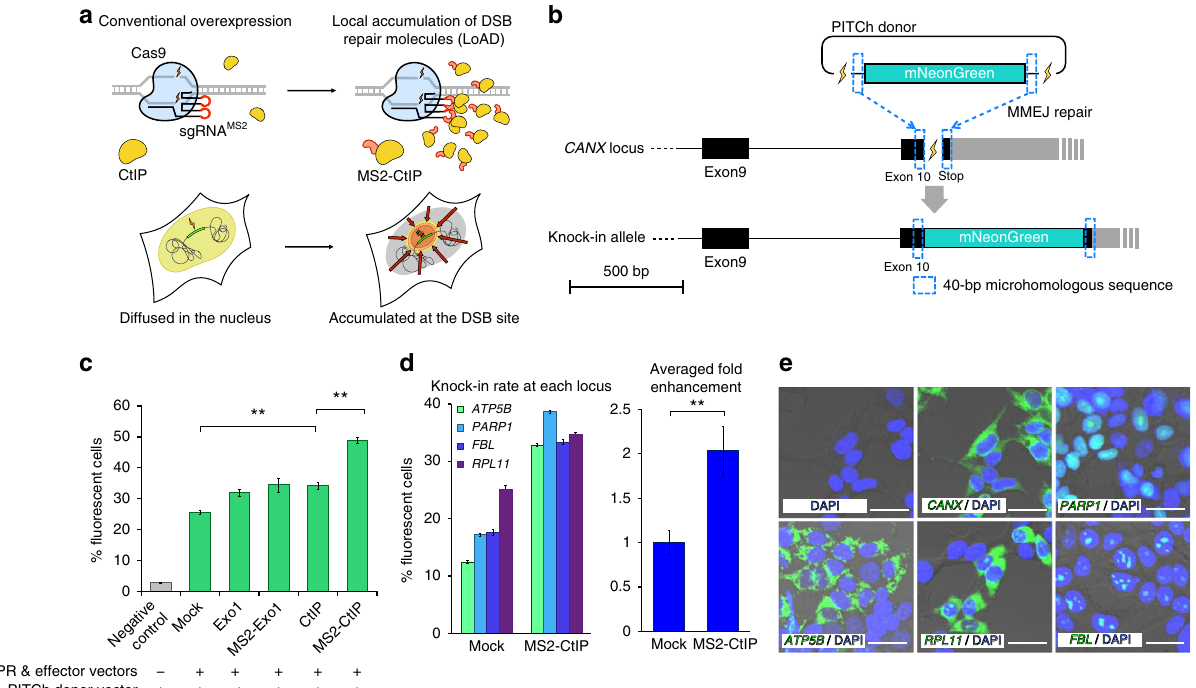
Fig. 1 Enhancement of knock-in ef fi ciency with the LoAD system. a Schematic of conventional overexpression and the LoAD system. Effector proteins such as CtIP can accumulate at the DSB site via the interaction between MS2 RNA loop and MS2 coat protein, resulting in programmable genome editing. sgRNA MS2 , sgRNA with two MS2 RNA loops. b Schematic of PITCh-mediated knock-in of fl uorescent protein gene, harnessing MMEJ for the prede fi ned, seamless gene cassette integration. This schematic only shows gene targeting in the CANX locus, but other gene loci such as ATB5B , PARP1 , FBL , and RPL11 were targeted in a similar way. c Knock-in frequency at the CANX locus measured by FACS analysis. The recruitment of MS2-CtIP with the LoAD system resulted in about 50% gene knock-in without any selection. Data are expressed as means ± s.e.m. ( n = 3). ** P < 0.01 (Student ’ s t -test). d The effect of MS- CtIP LoADing was not locus-dependent. The average rate of fold activation was about 1.8-fold. Data are expressed as means± s.e.m. ( n = 3). ** P < 0.01 (Student ’ s t -test). e The intended fl uorescence localization was observed at all gene loci (CANX, endoplasmic reticulum; PARP1, nucleus; ATP5B, mitochondrion; RPL11, nucleolus, and cytoplasm; FBL, nucleolus). Bar, 30 μ